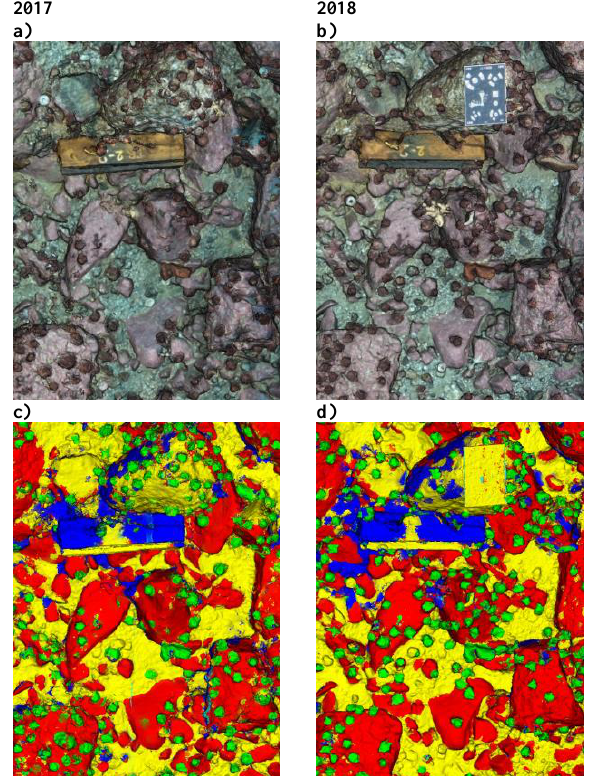
Figure 6. Example of 3D textured mesh models colored according to the RGB (a, b) and semantic segmentation (c, d) depicting the same areas from 2017 and 2018 obtained using the 2018 as reference epoch. Beside the evident changes in sea starts and urchin number and distribution, it can be noticed that the iron block slightly moved between the two